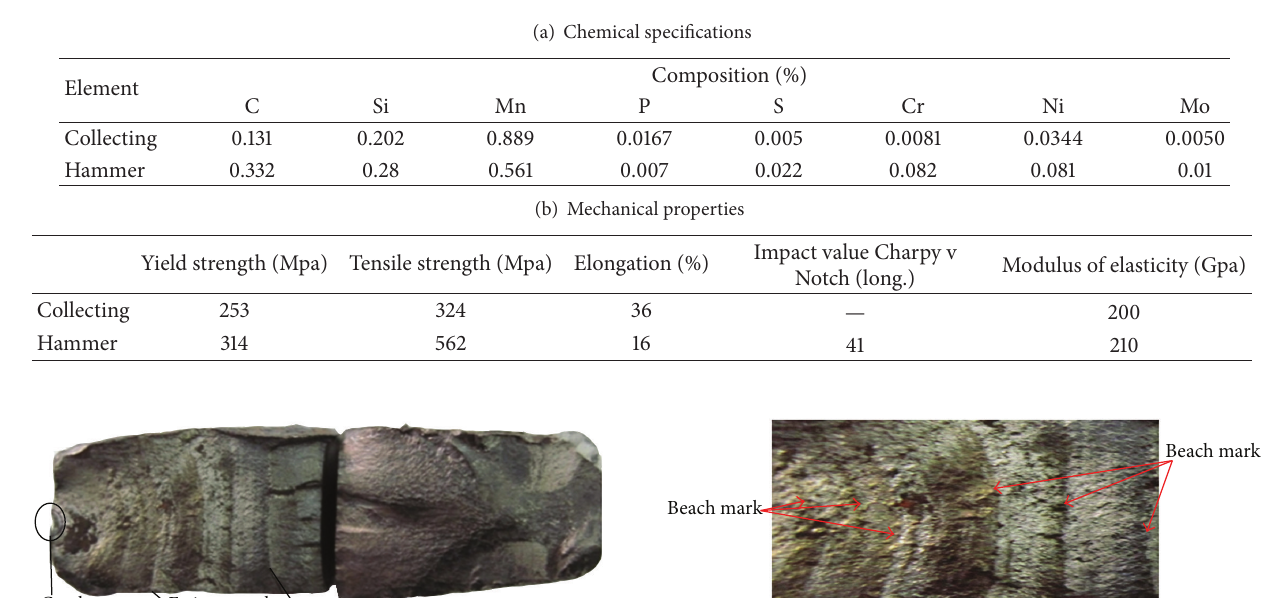
Table 2: Characteristics of examined colleting plates and rapping hammer.